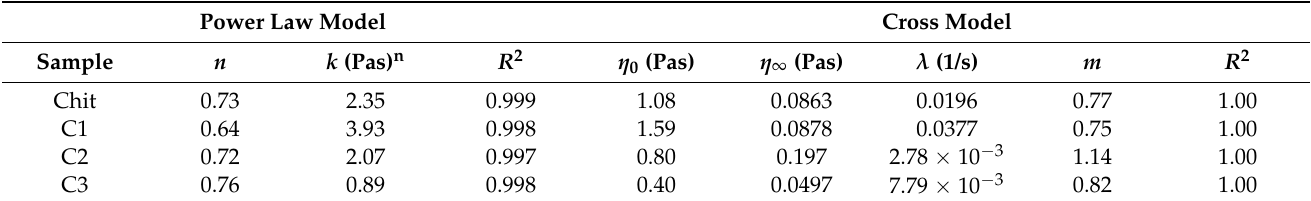
Table 1. Rheological parameters obtained from power law model and Cross model for Chit solution and Chit/clay mixtures at 25 ◦